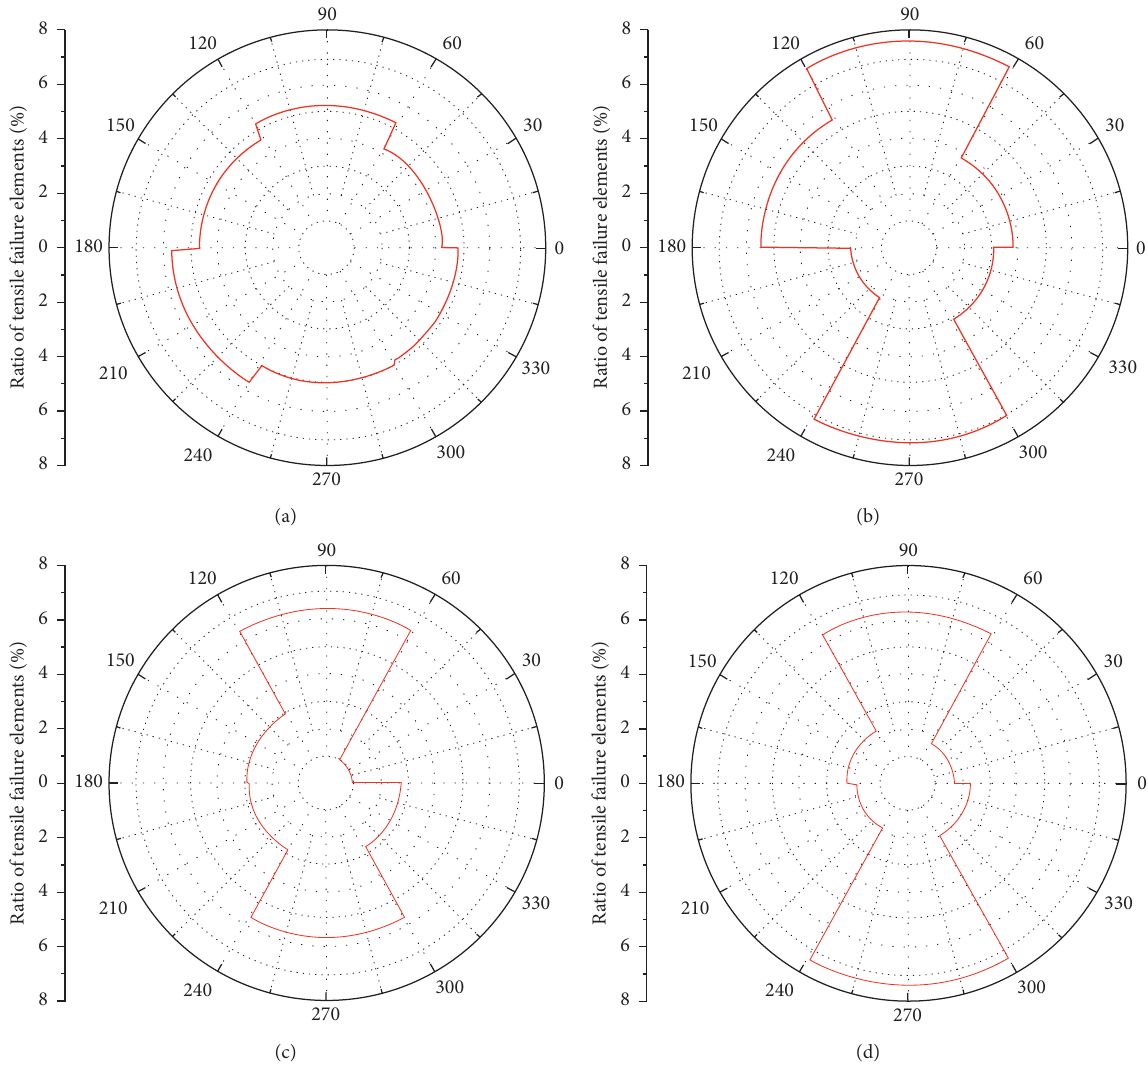
Figure 17: Distributions of the ratio of tensile failure elements along the edge of the borehole under the different values of P P x � 5MPa. (a) P x � 5MPa, P y � 5MPa. (b) P x � 5 MPa, P y � 15MPa. (c) P x � 5MPa, P y � 25MPa. (d) P x � 5MPa, P y �